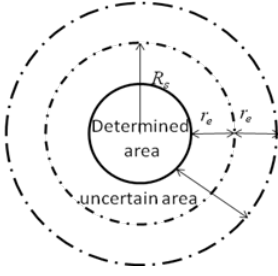
Figure 1. Node sensing model.